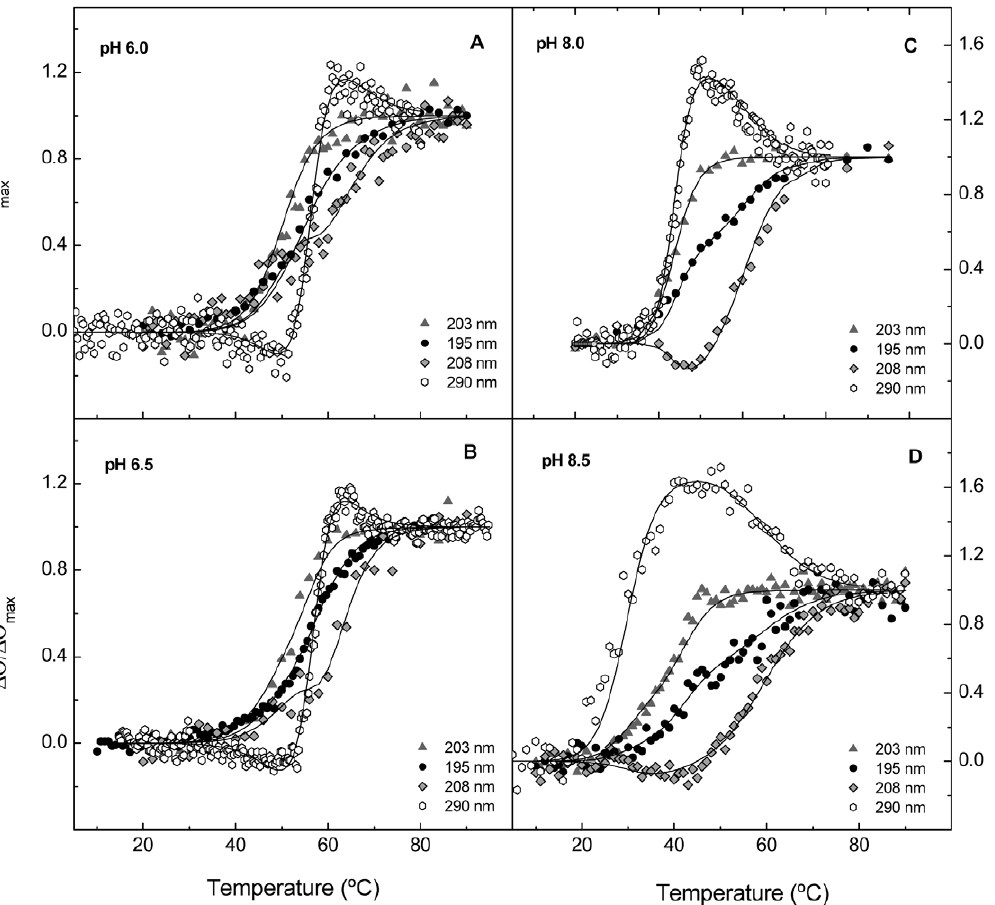
Figure 3. Influence of pH on Cpl-7 thermal stability. Panels ( A ) to ( D ) depict full-length protein denaturation profiles at 195 nm (circles), 203 nm (triangles), 208 nm (diamonds) and 290 nm (hexagons) at different pHs. Continuous lines are the theoretical curves calculated as indicated in the text using the fitting parameters shown in Table 2. Measurements were carried out in 20 mM Pi buffer (pH 6.0, 6.5 and 8.0) and 25 mM sodium borate buffer (pH 8.5) at a scan rate of 20 u C h 2 1 (195, 203 and 208 nm) and 40 u C h 2 1 (290 nm).